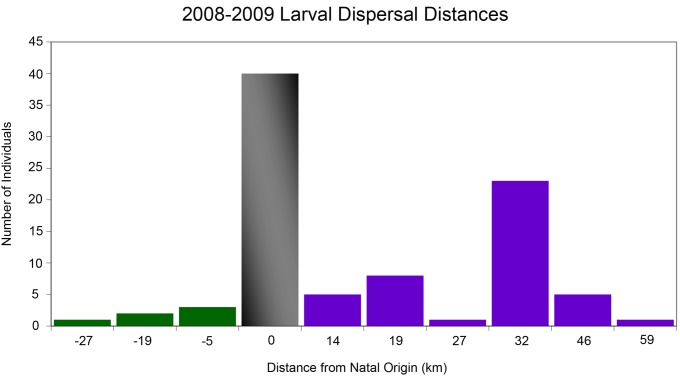
Mean larval dispersal distances (km) of all (n = 89) YOY fish collected in 2008 and 2009.Green histograms and negative values indicate southward dispersal. Purple histograms and positive numbers indicate northward dispersal, and the grey histogram depicts the number of YOY that self-recruited (i.e. that were spawned at and settled to the same reef).